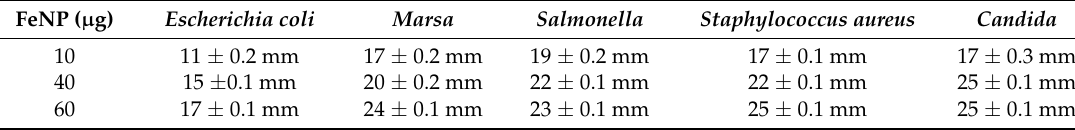
Table 2. Antimicrobial effect of Acacia nilotica FeNP on human